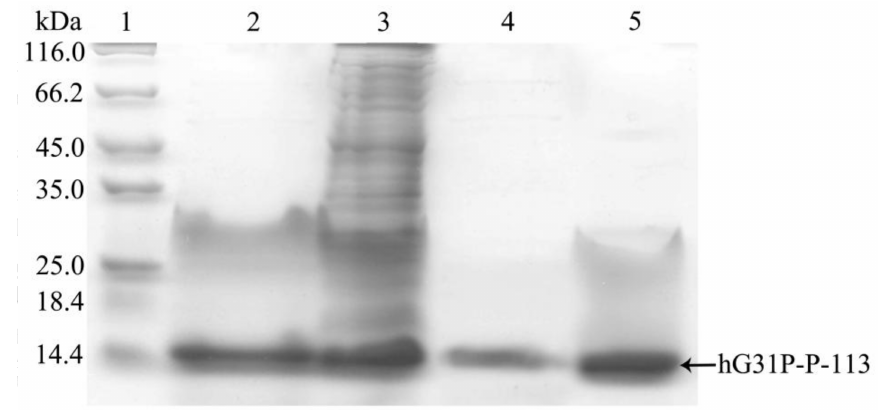
Figure 2. Sodium dodecyl sulfate (SDS)–polyacrylamide gel electrophoresis (PAGE) analysis of recombinant hG31P-P-113 expressed in E. coli BL21.